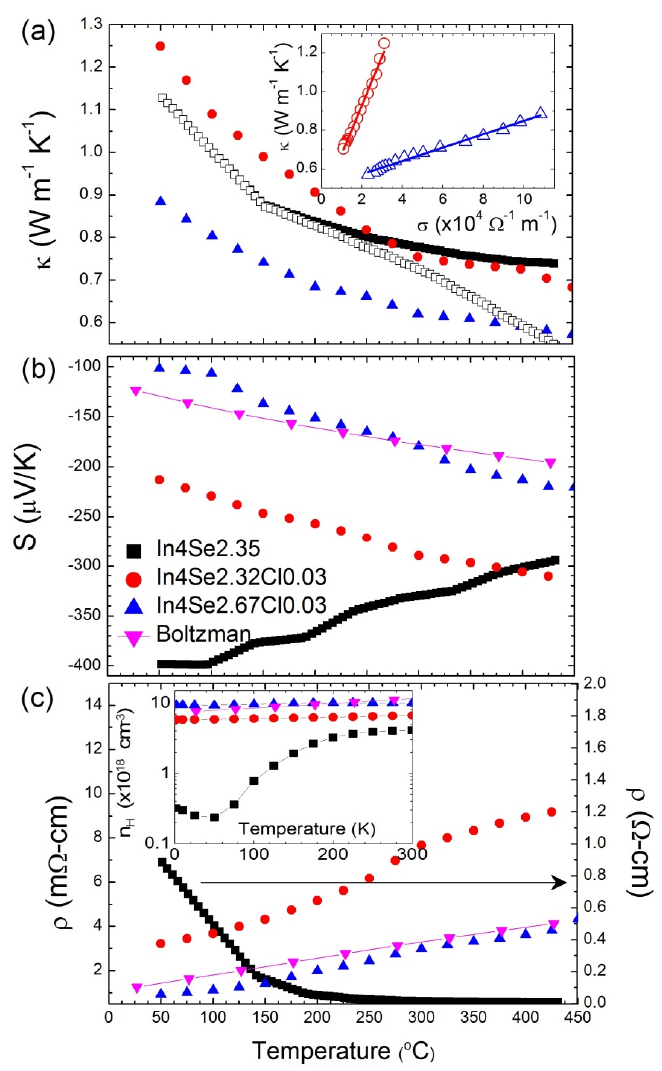
Figure 13. Temperature-dependent thermoelectric properties of ( a ) thermal conductivity, ( b ) Seebeck coefficient, ( c ) electrical resistivity, and Hall carrier concentration (inset of ( c )) for In 4 Se 2.35 [15], In 4 Se 2.32 Cl 0.03 , and In 4 Se 2.67 Cl 0.03 bulk crystals [29]. Reprodueced with permission from WILEY-VCH Verlag GmbH & Co., 2011